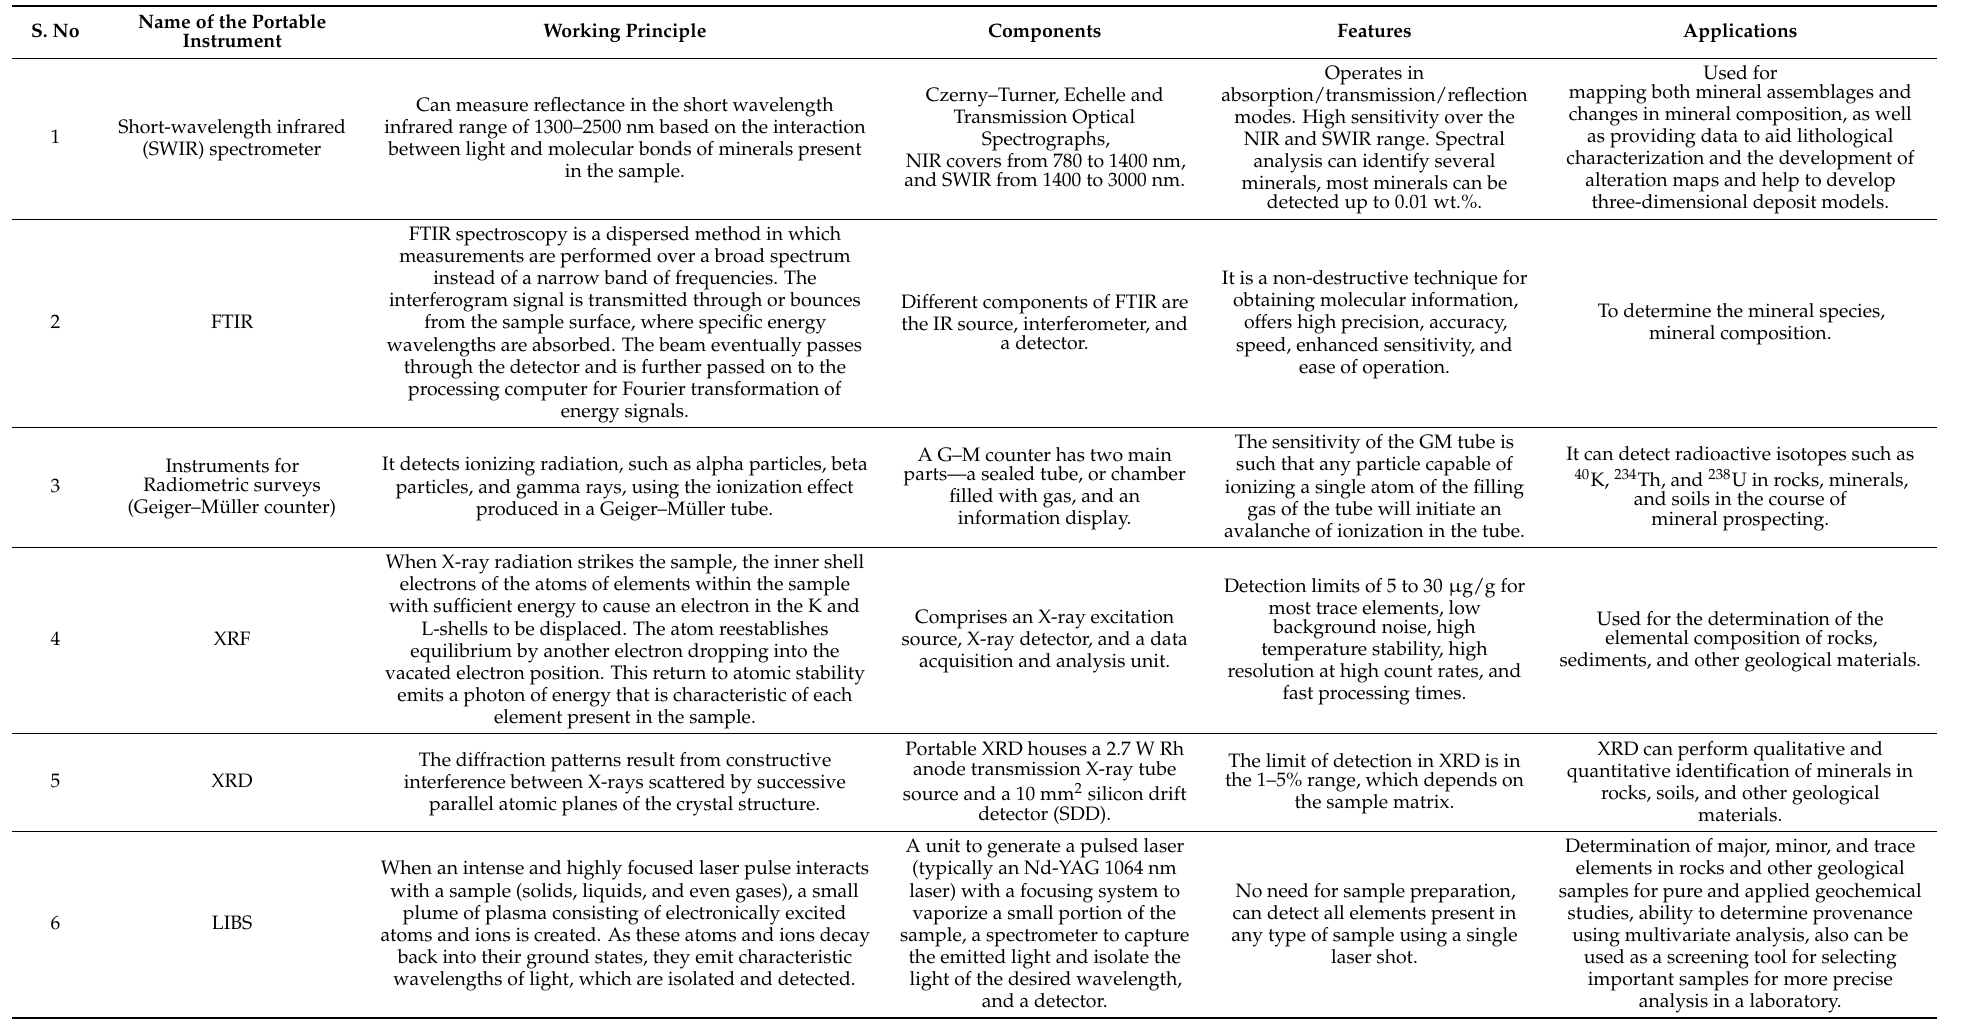
Table 3. A summary of all described portable instruments with their working principle, components, parameters, features, and